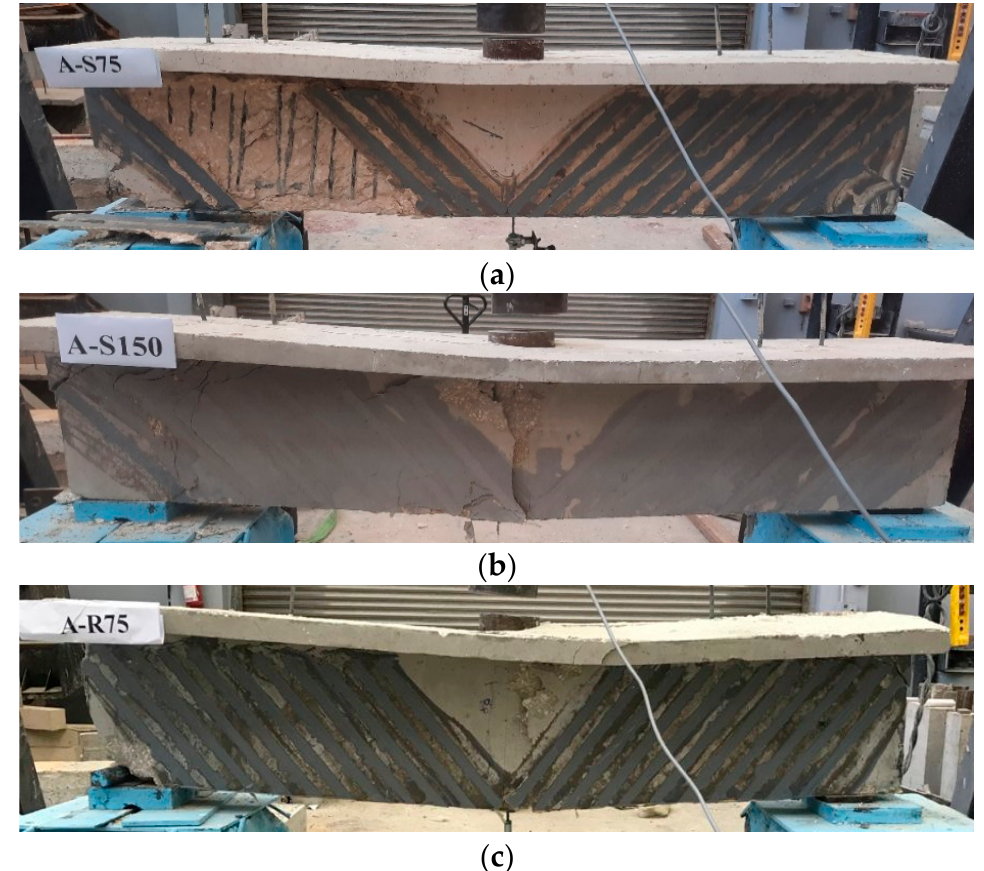
Figure 5. Failure modes of group A specimens. ( a ) A-S75 ( b ) A-S150( c ) A-R75.